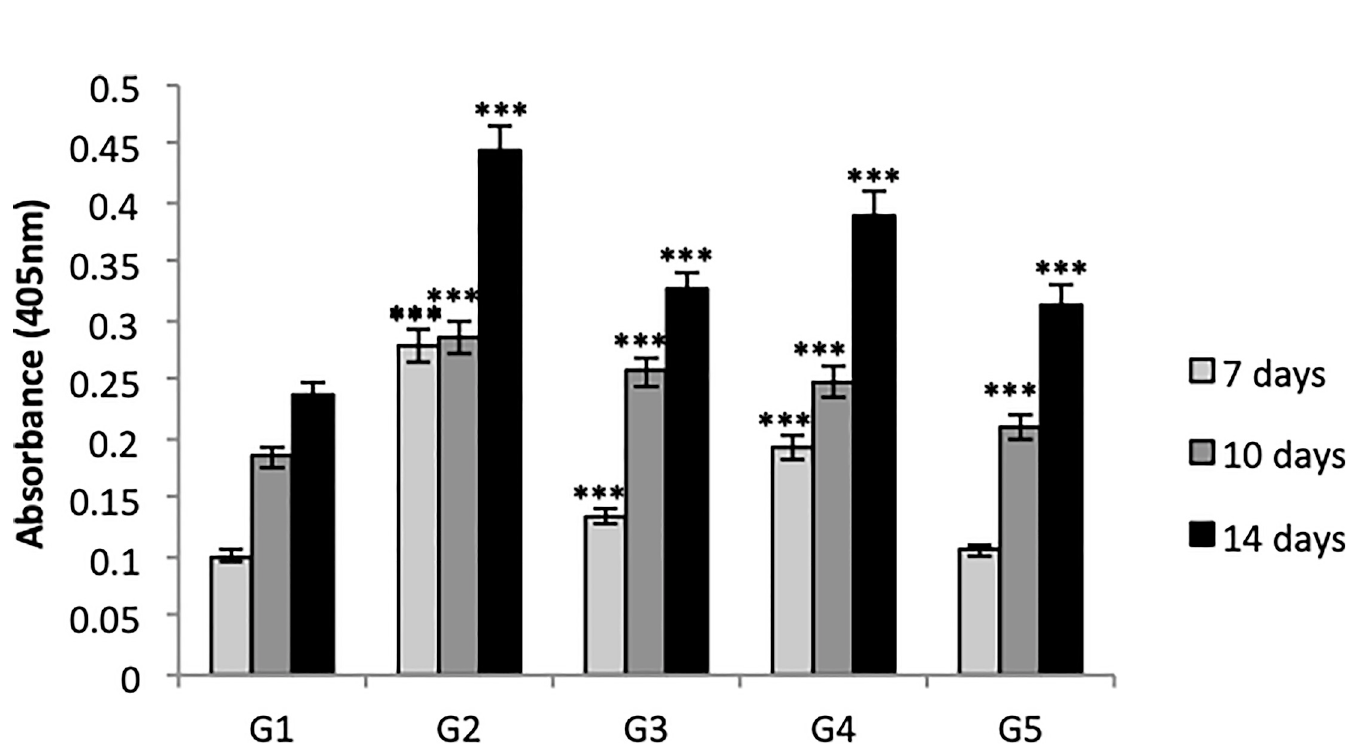
Fig 9. Quantitative analysis of mineral nodules by Alizarin Red in G1, G2, G3, G4, and G5 at 7, 10, and 14 days. Bars indicate the highest osteogenic potential of cultures according to investigated material +/- standard error. One-way ANOVA followed by Tukey’s test. ��� = p < 0.001 compared to the G1 control group.